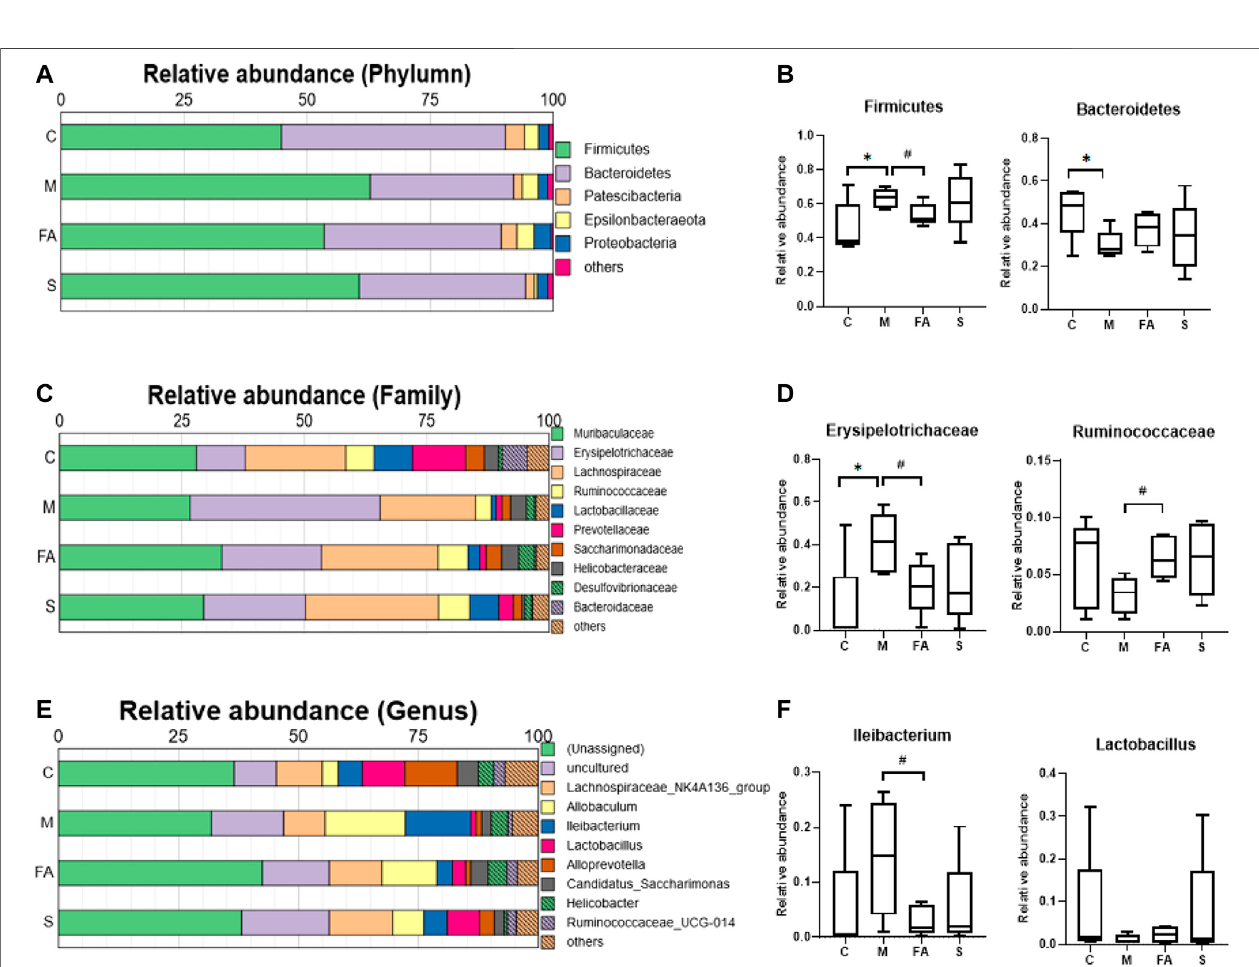
Frontiers in Pharmacology |